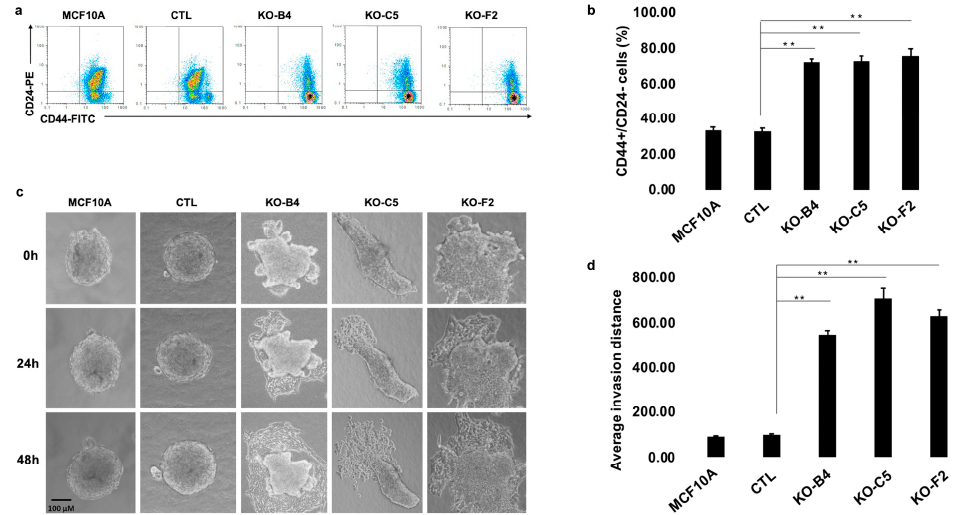
Figure 3. CYLD inactivation promotes the development of stem cell and invasive phenotypic characteristics. ( a ) Representative flow cytometric detection of CD44 and CD24 in control (MCF10A, CTL) and CYLD-deficient MCF10A (KO-B4, KO-C5, and KO-F2) cells for the expression of CD44 and CD24 markers. ( b ) Relative representation of CD44 +/ CD24 − cells in control (MCF10A, CTL) and CYLD-deficient MCF10A (KO-B4, KO-C5, and KO-F2) cells. Average values ( +/ − SE) from three independent experiments are shown (** p ≤ 0.01). ( c ) Representative images of a three-dimensional invasion assay from control (MCF10A, CTL) and CYLD-deficient MCF10A (KO-B4, KO-C5, and KO-F2) cells at time points of 0, 24, and 48 h. ( d ) Representation of the average invasion distance of CYLD-deficient MCF10A (KO-B4, KO-C5, and KO-F2) cells. Average values ( +/ − SE) from three independent experiments are shown (** p ≤ 0.01).